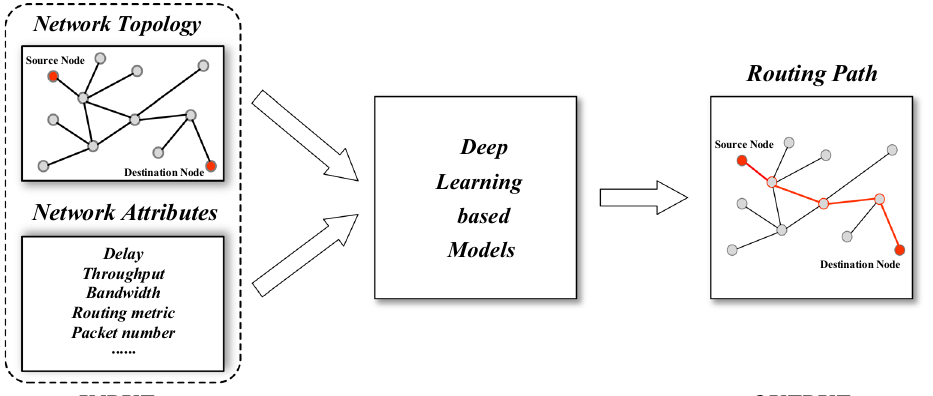
Figure 6. Scheme of deep learning based routing model.